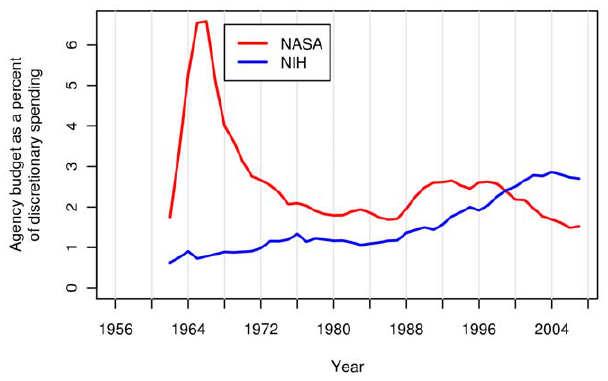
Figure 4. National Aeronautics and Space Administration (NASA) and National Institutes of Health (NIH) budgets during the last six decades. Budgets for NASA and NIH as a percent of US federal discretionary spending.